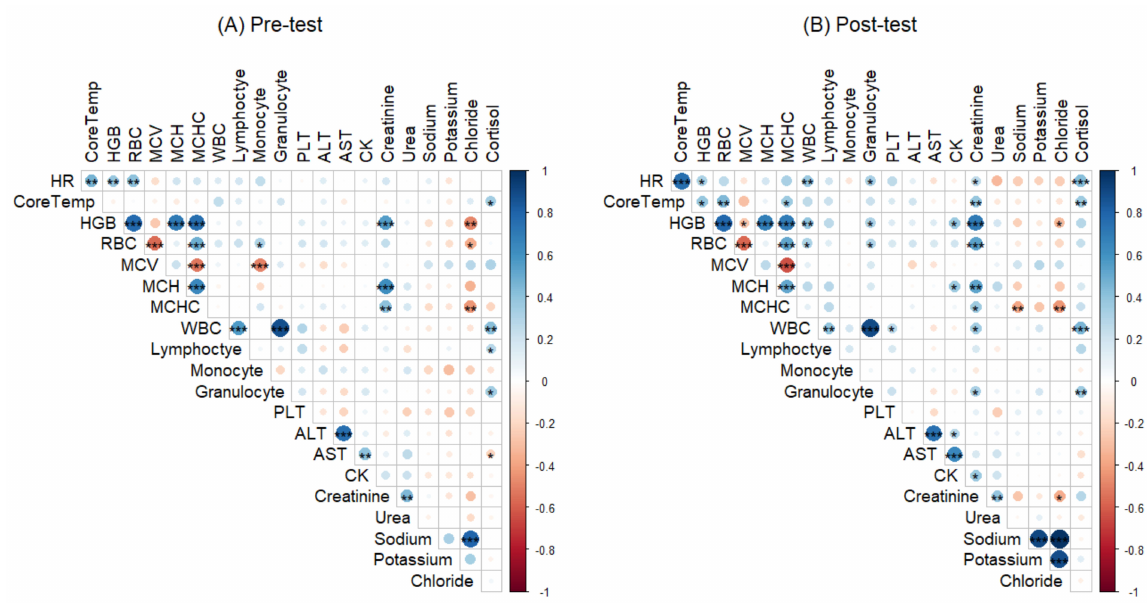
Figure 1. Correlations between heat tolerance outcomes (Tc and HR) and the haematological, biochemical and hormonal biomarkers ( A ) pre-test and ( B ) post-test. Significant * p < 0.05, ** p < 0.01, *** p < 0.001; WBC: White blood cell; RBC: Red blood cell; MCV: Mean corpuscular volume; MCH: Mean corpuscular haemoglobin; MCHC: Mean corpuscular haemoglobin concentration; CK: creatine kinase; ALT: alanine transaminase; AST: aspartate transaminase. Dark blue to dark red colour indicates Pearson’s correlation coefficient from 1 to − 1, respectively. Table 5. Predictive relationship between post-test biochemical and hormonal variables and heat intolerance.